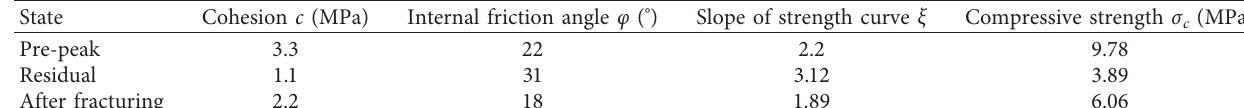
Table 1: Mechanical parameters of coal in different states.